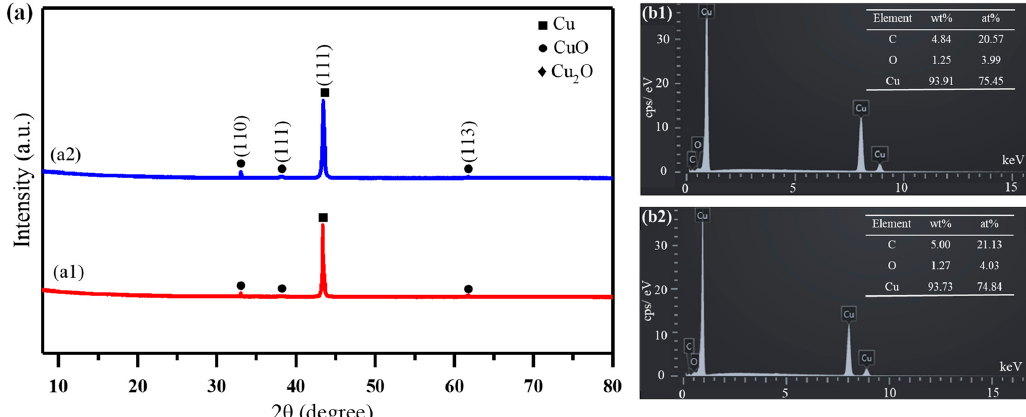
the Cu films ablated by a 2.69 J/cm 2 ps − laser: ( b1 ) without the plasma assistance and ( b2 ) with the 30 ◦ plasma